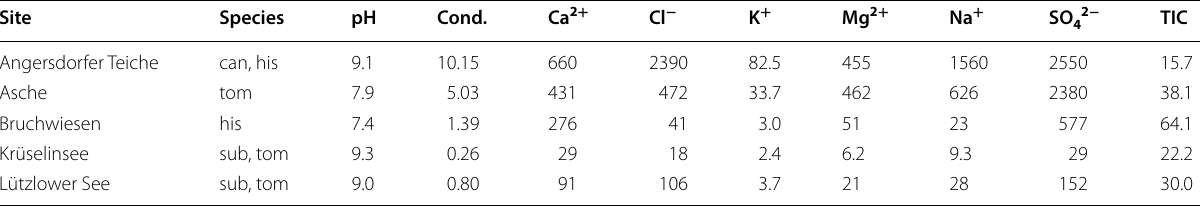
Sites and species are abbreviated as first three letters. Listed are pH, and conductivity (mS cm − 1 ) and concentrations of Ca 2 + , Cl − , K + , Mg 2 + , Na + , SO 42 − , and TIC (mg L − 1 )